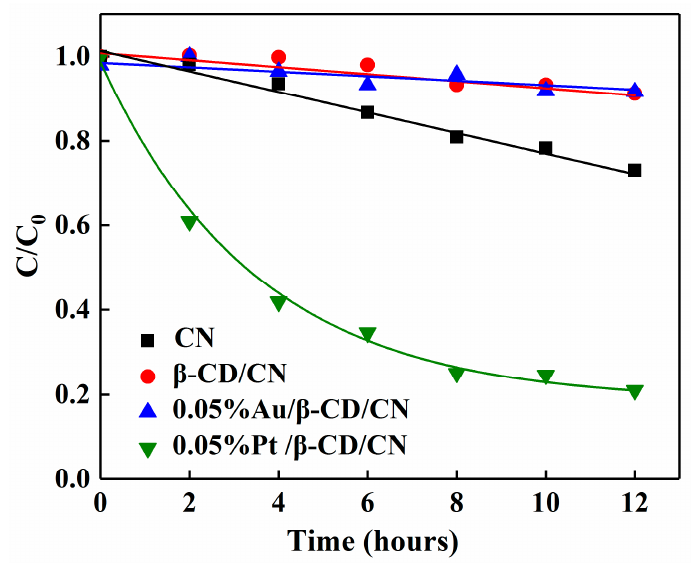
Figure 7. Photodecomposition of H 2 O 2 in an aqueous CN suspension with a different metal co-catalyst.